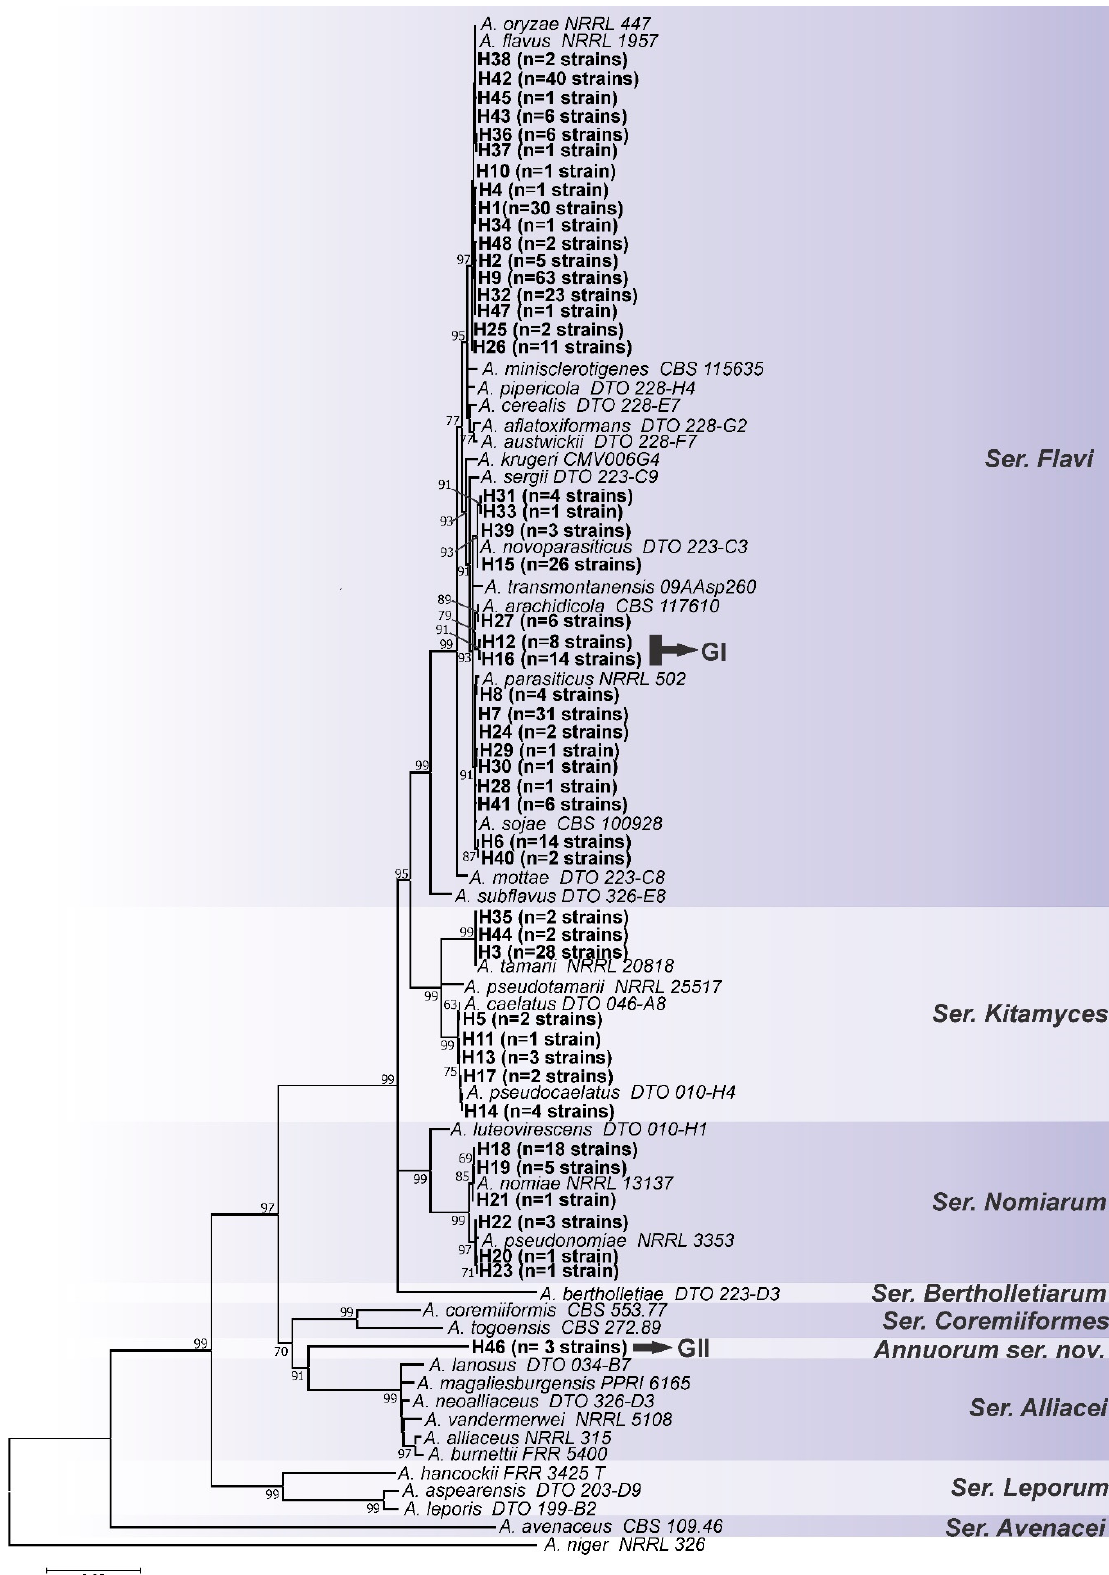
Figure 4. Maximum-likelihood tree of Aspergillus section Flavi based on combined dataset sequences ( CaM+BenA+RPB2 ). Haplotypes obtained in this study are indicated by the letter H in bold. Only bootstraps ≥ 60% are shown. Aspergillus niger is the outgroup.